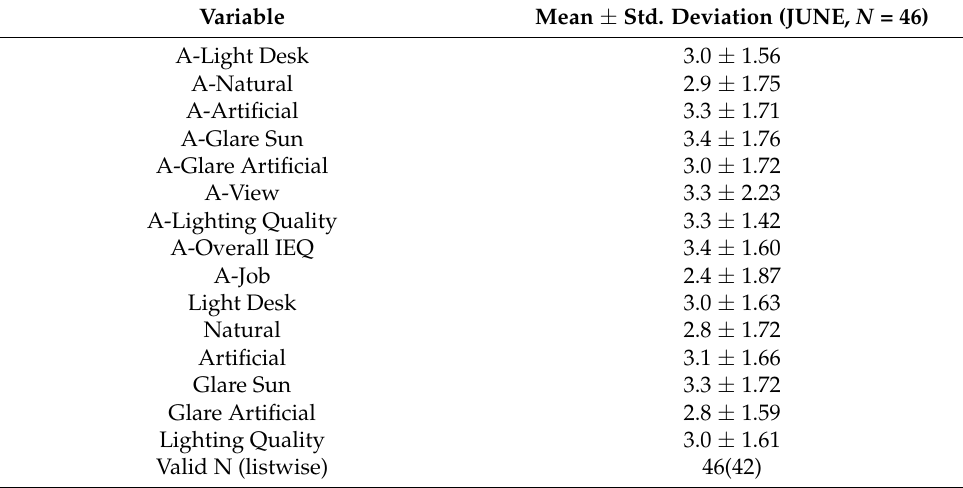
Table 8. Descriptive statistics analysis of all 15 satisfaction variables (1 = very satisfactory, 7 = very unsatisfactory).